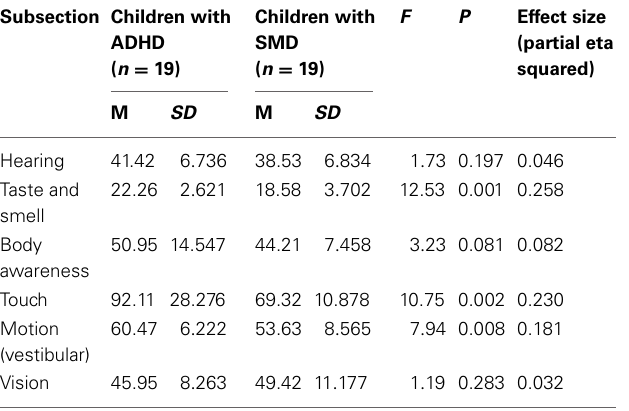
Table 1 | Results of multivariate analyses of variance (MANOVA) comparing test scores on the ESP between children with ADHD and children with